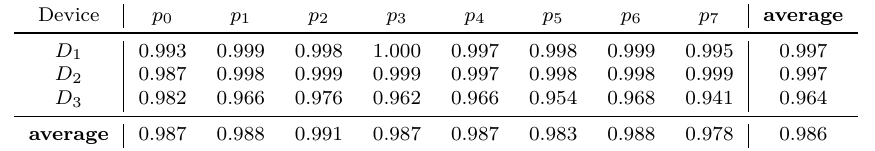
Table 5: Empirical probability p j to recover m [ j ] from a single trace using both points.